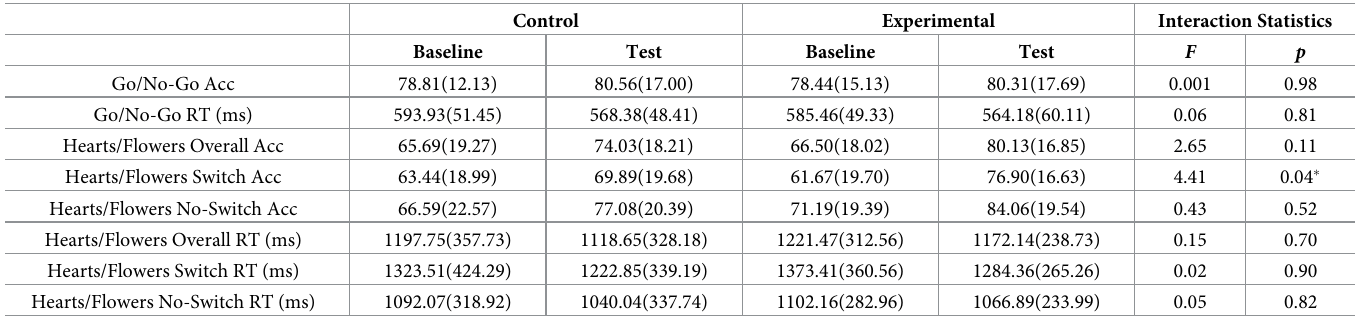
Table 3. Descriptive statistics, M(SD), for accuracy (Acc) and reaction time (RT) on the Go/No-Go and Hearts and Flowers